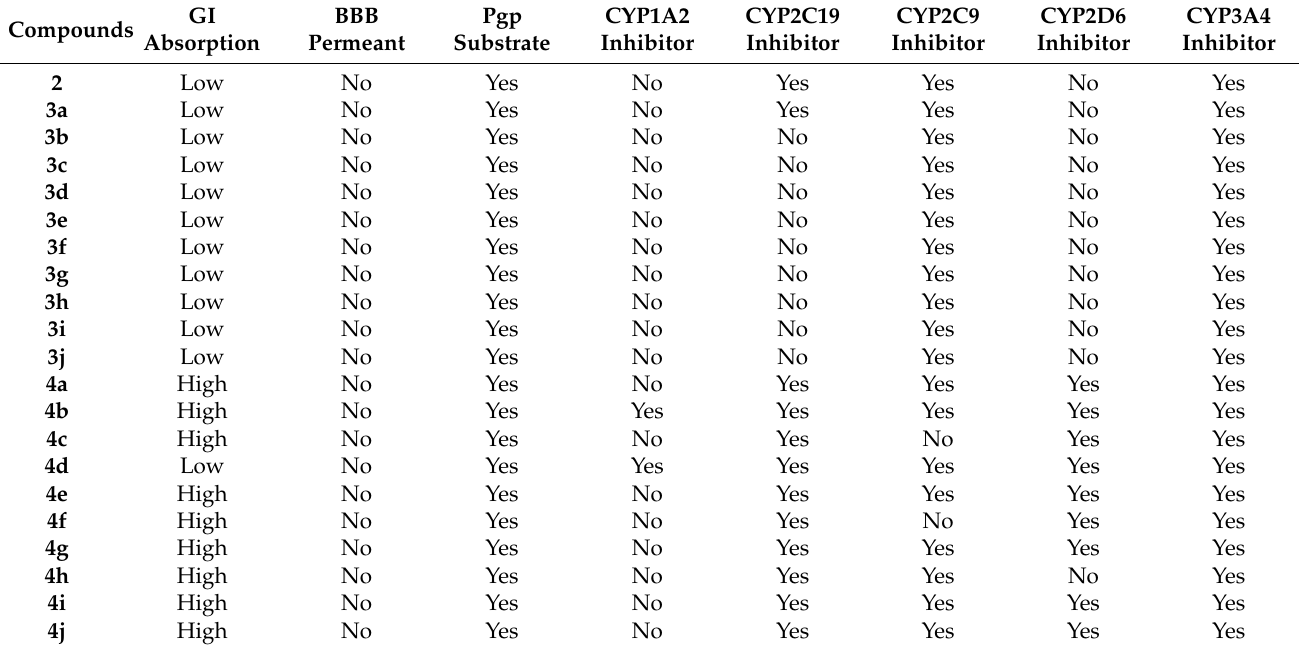
Table 5. Selected ADME parameters of oxazolidinones 2 , 3a–j , 4a–j